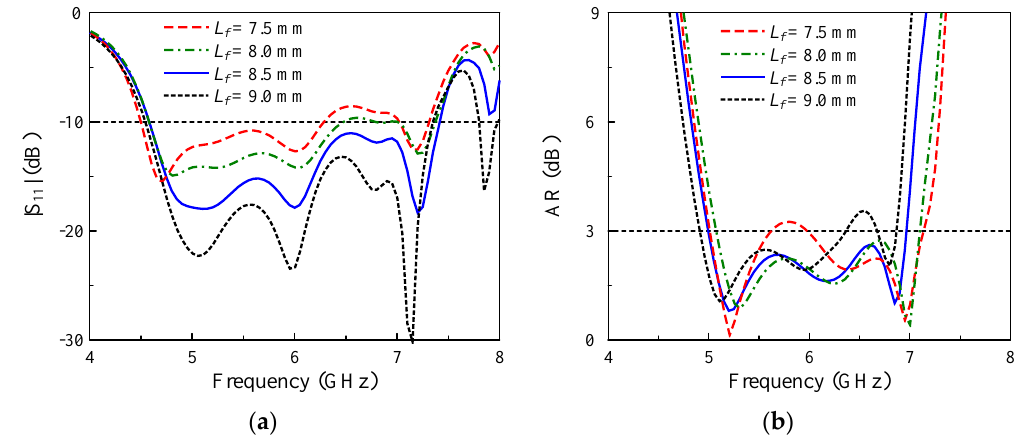
Figure 8. Simulated ( a ) |S 11 | and ( b ) AR for the non-uniform based antenna with different feeding positions, L f .